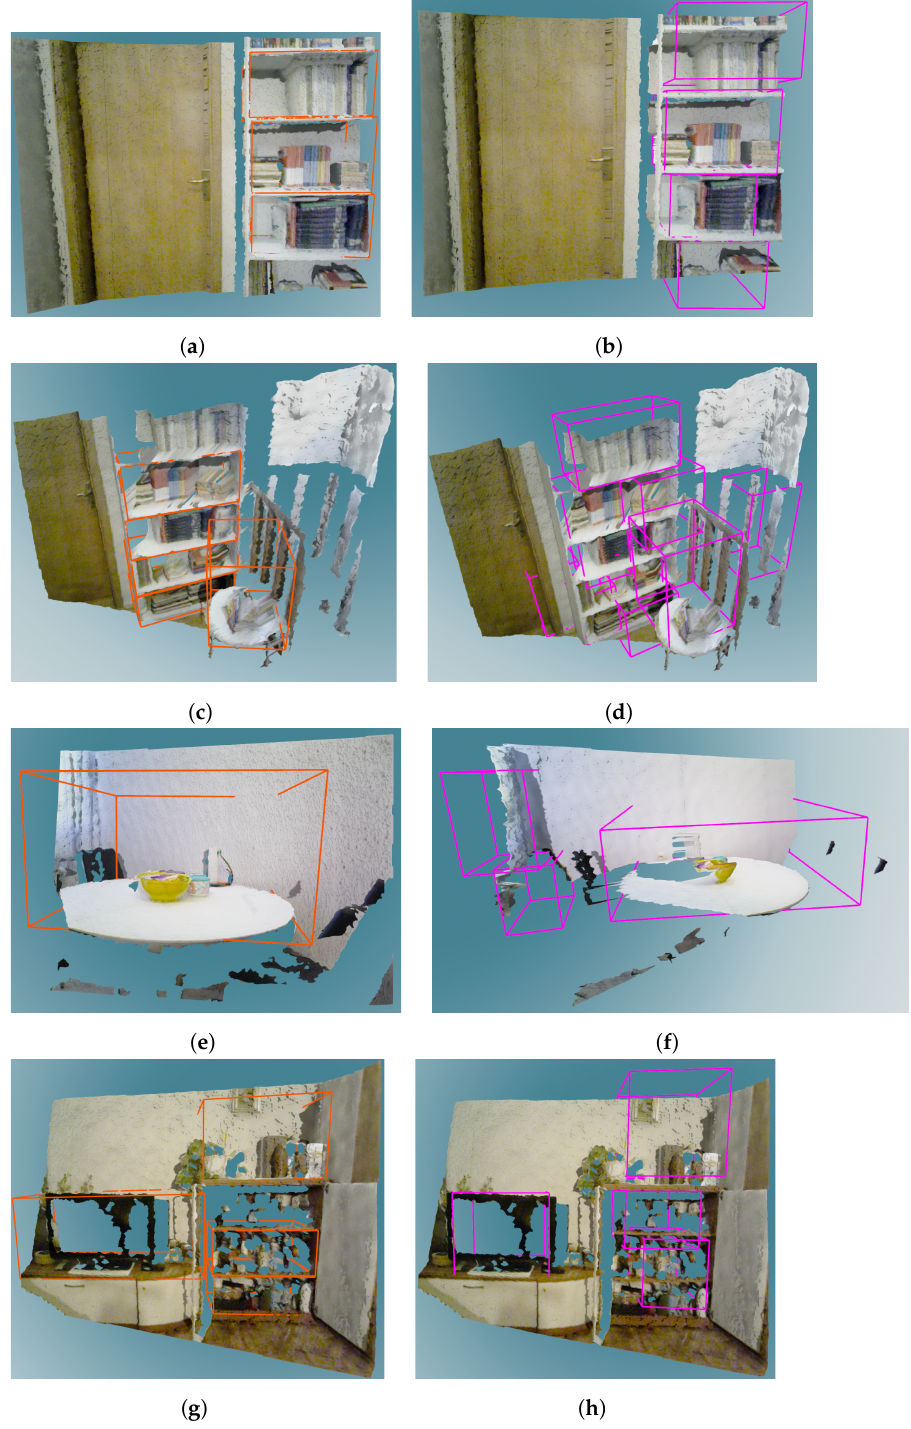
Figure 14. Examples of storage volumes in depth images contained in a real dataset. The left column shows ground truth annotations of storage volumes in the selected furniture classes. The right column shows the storage volumes predicted in these furniture models by the VoteNet detector. ( a , b ) Show a close-up view of a library bookshelf, ( c , d ) Show a library bookshelf seen from a distance, ( e , f ) Show a dining table, ( g , h ) Show a scene from the Family